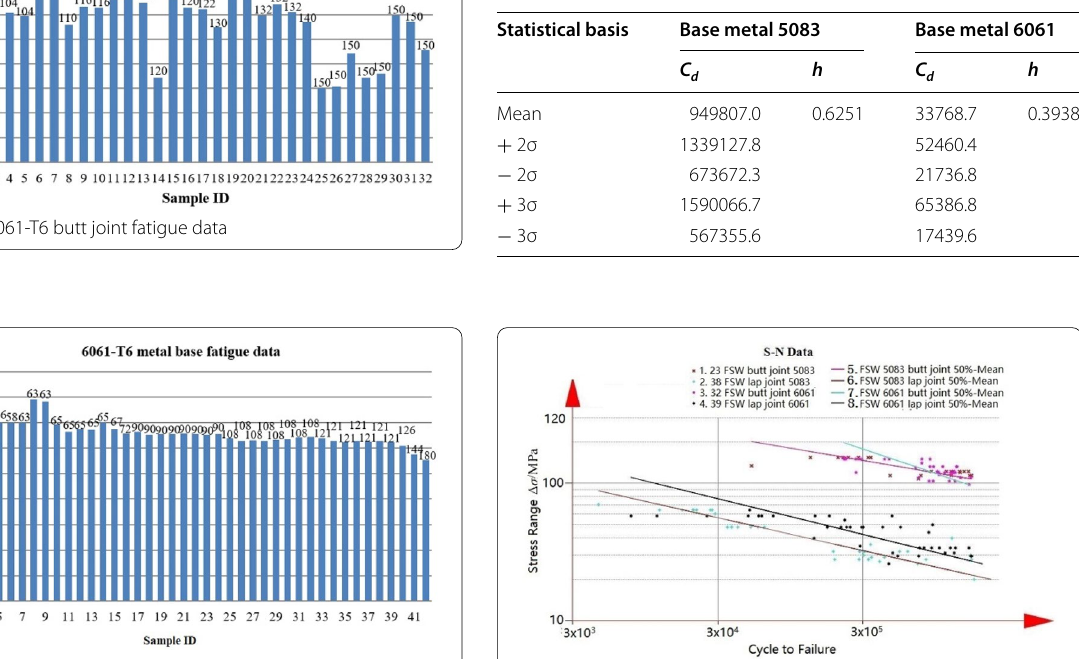
Table 3 Nominal stress fitting curve parameters of